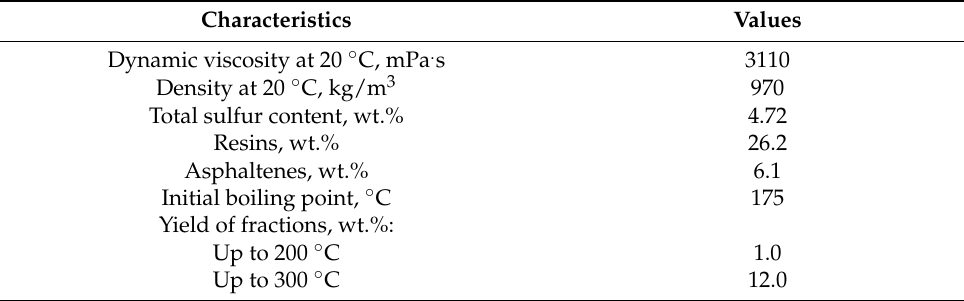
Table 2. Physical and chemical properties of heavy crude oil sample.